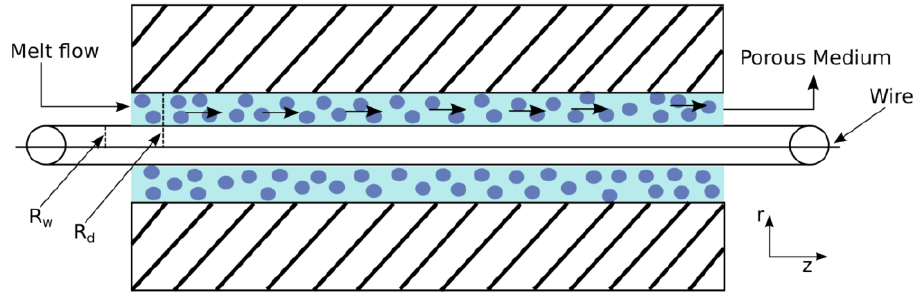
Figure 2. Wire coating process in a porous medium in a pressure type coating die.